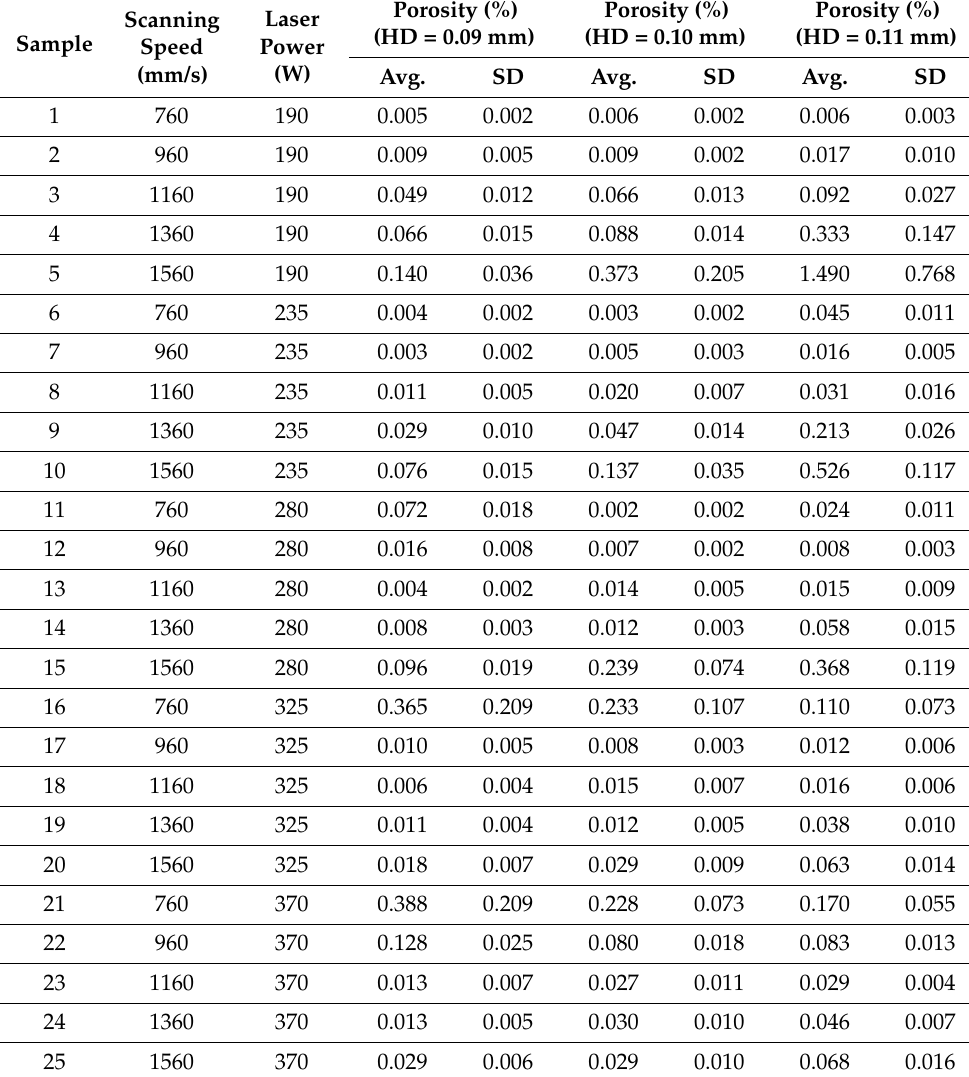
Table 5. Porosity tracking table.